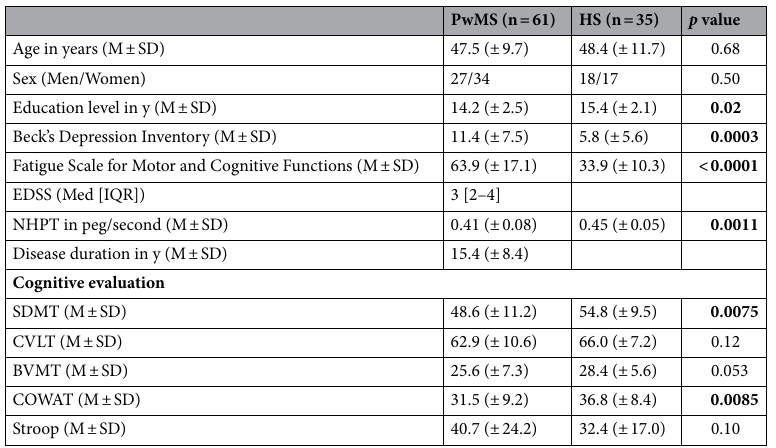
Table 1. Demographics and neuropsychological scores of the PwMS and HS group. p values were derived from two-sample t-tests, and from a Chi-square test for the variable sex. M mean, SD standard deviation, IQR interquartile range, y